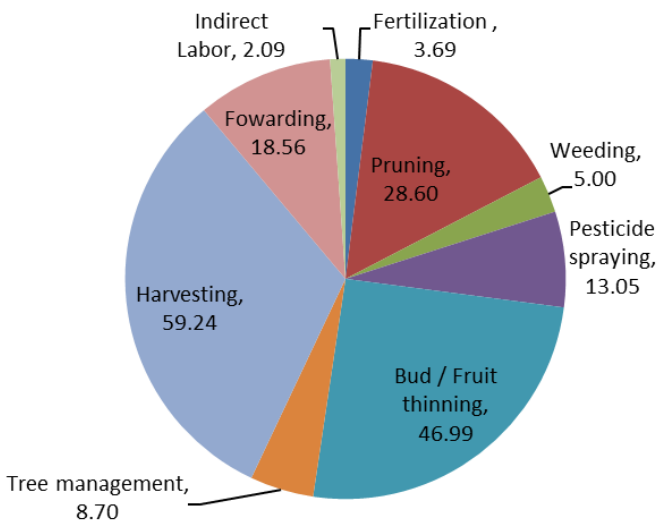
Figure 2. Typical time spent on each work category of persimmon cultivation (rearranged from [9] and [10]).